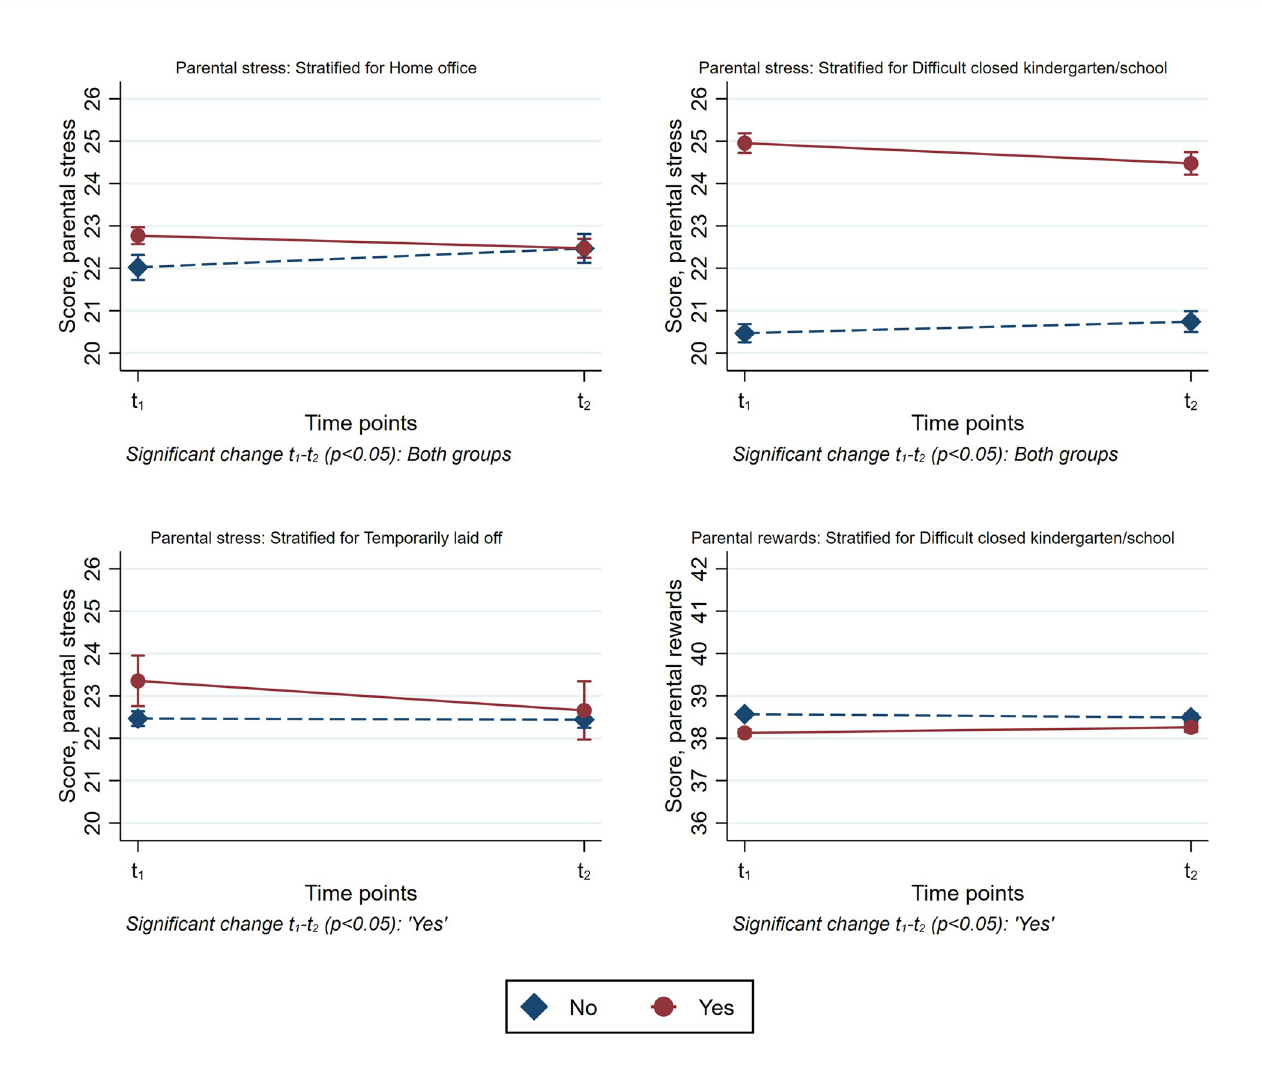
Fig 2. Stratified results for parental stressors and parental rewards. Time point 1 in April-May 2020. Time point 2 in April-May 2021.